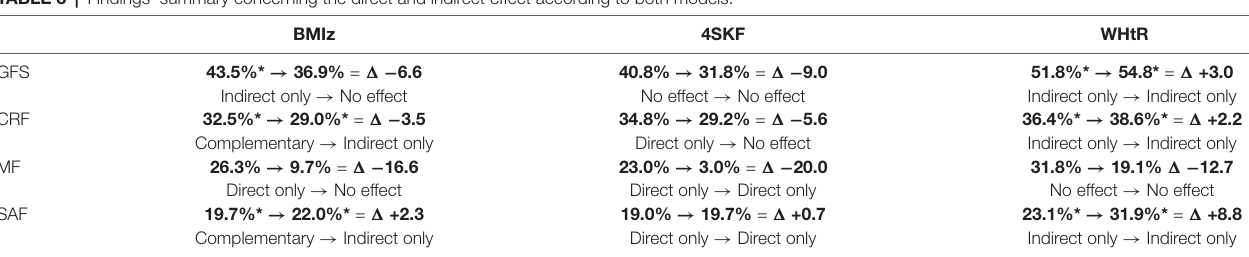
TABLE 3 | Findings’ summary concerning the direct and indirect effect according to both